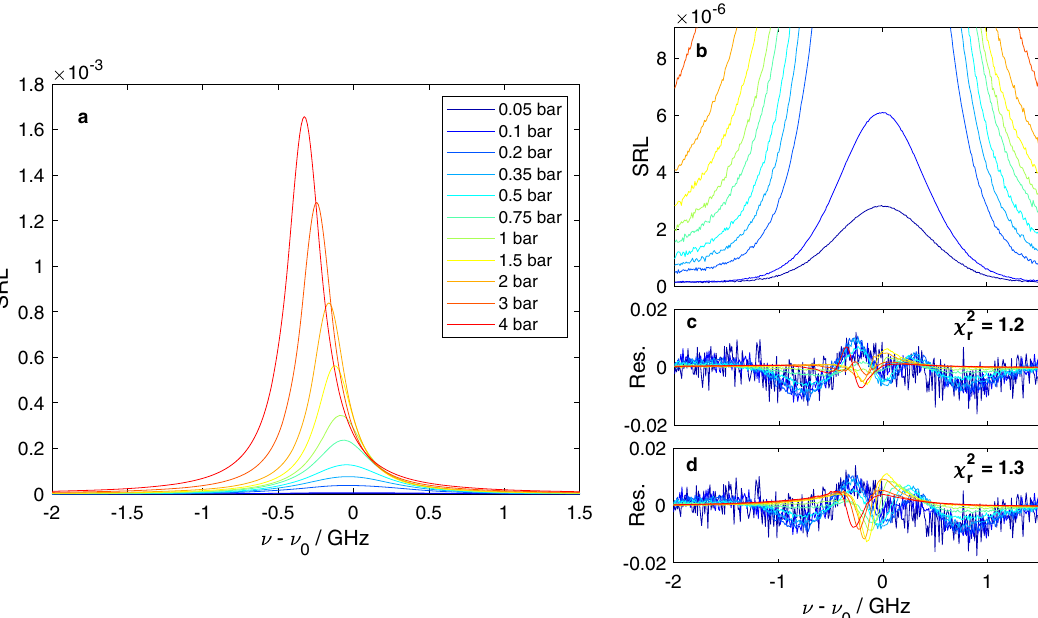
Fig. 2 Stimulated Raman scattering metrology of H 2 . a Set of spectra at different pressures plotted in an absolute SRL scale. Legend applies to all panels. b Zoom of a showing a detail of the spectra acquired at pressures equal to 0.05 and 0.1 bar. c Residuals (data — model) normalized to the corresponding spectral maxima, obtained from a global fi tting with 5 free parameters and 3 fi xed to ab initio value. χ 2 r represents the reduced chi square of the fi t. d Residuals as above, obtained from a global fi tting with 2 free ( ν 0 , δ 0 ) and 6 fi xed parameters.